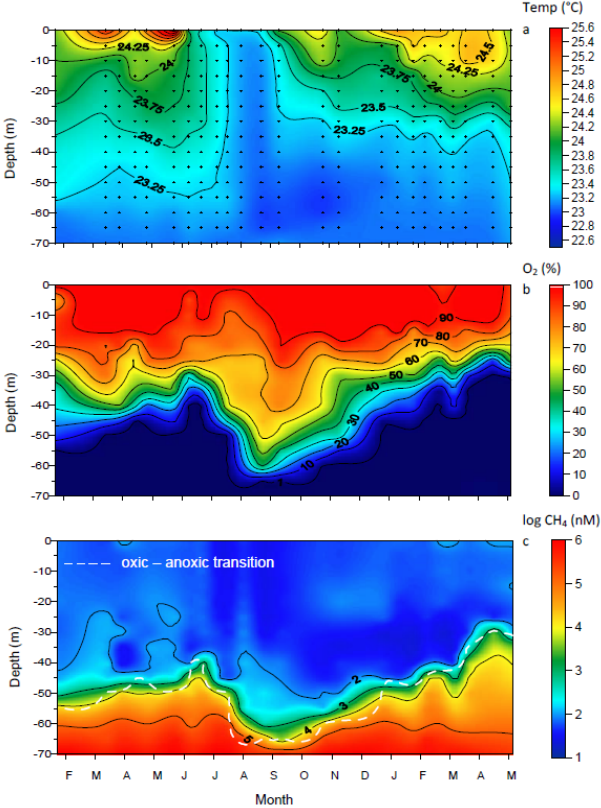
Figure 1. Temporal variability of (a) temperature ( ◦ C), (b) oxygen saturation (in percentage), and (c) the log-transformed CH 4 con- centration (nmolL − 1 ) in the mixolimnion of Lake Kivu, between February 2012 and May 2013. Small crosses in the figure (a) rep- resent each sampling points. The white dashed line represents the vertical position of the oxic–anoxic transition.